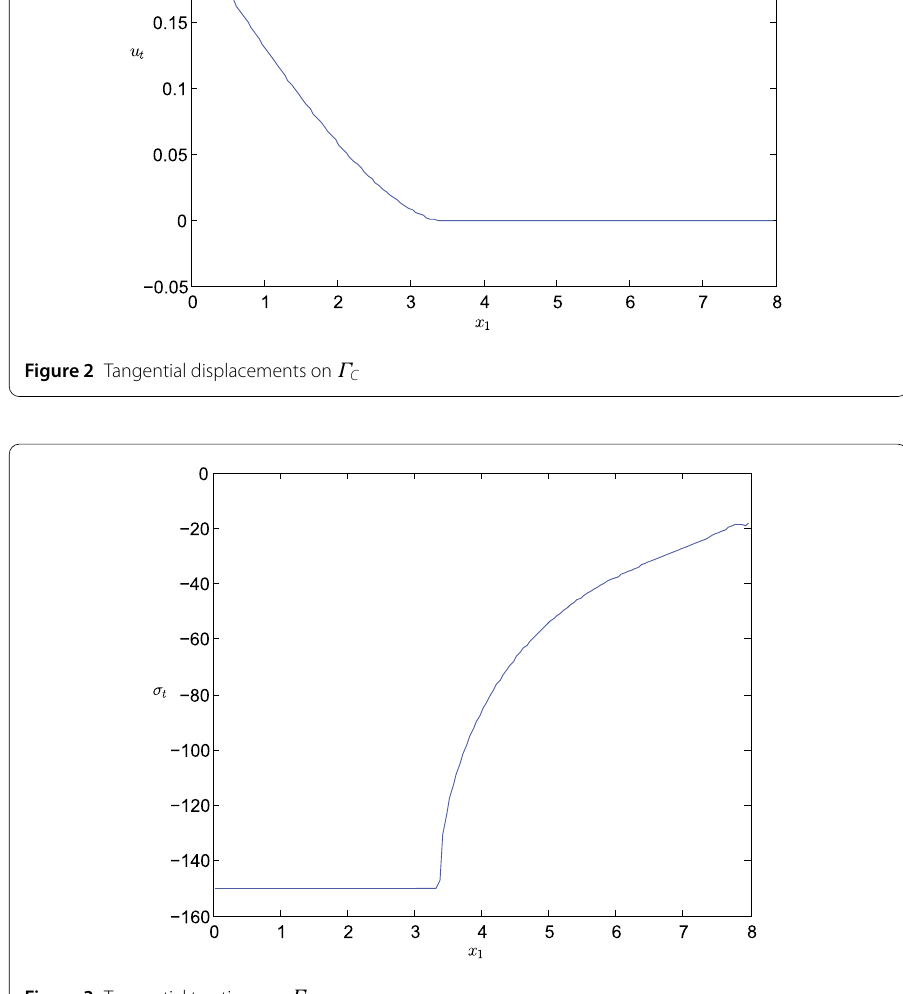
Figure 3 Tangential tractions on Γ